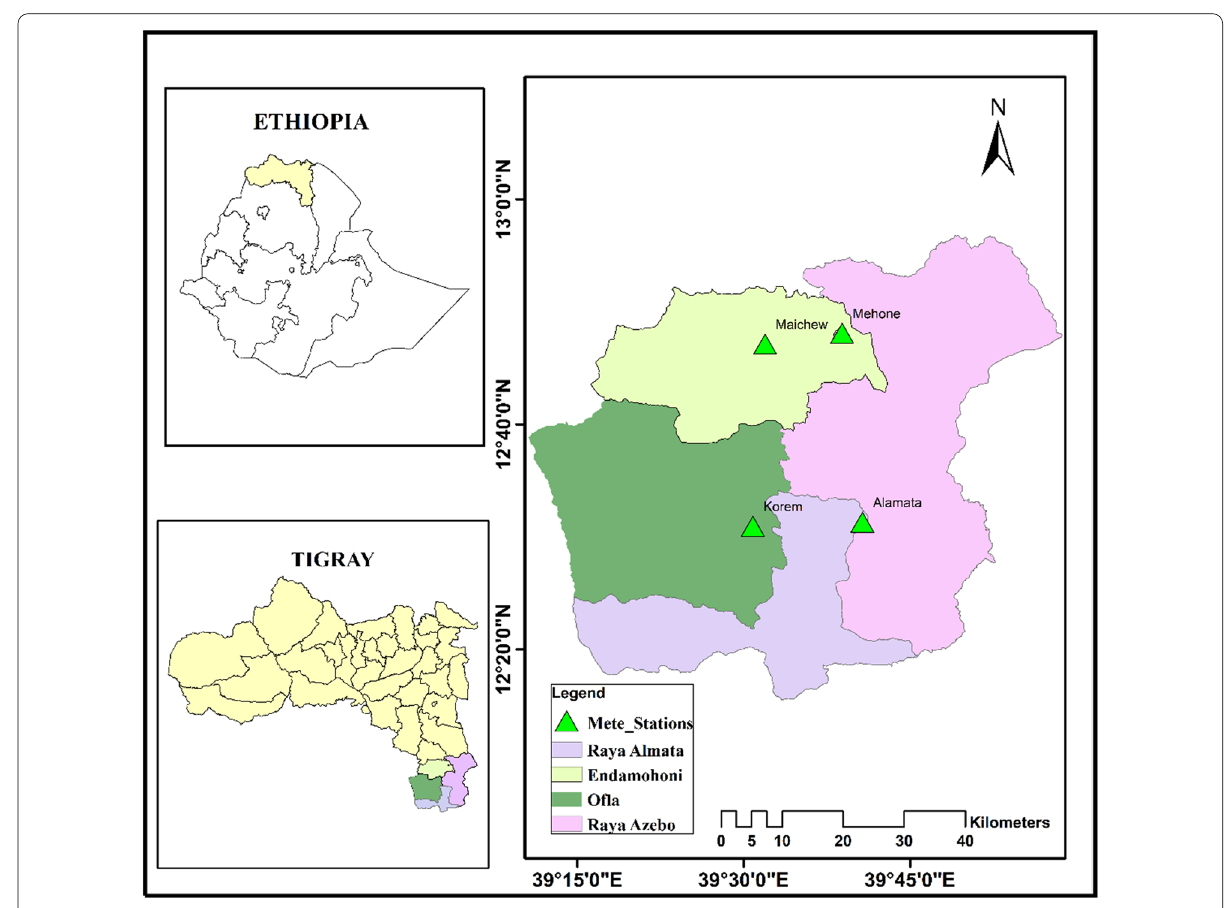
Fig. 1 Location of study area